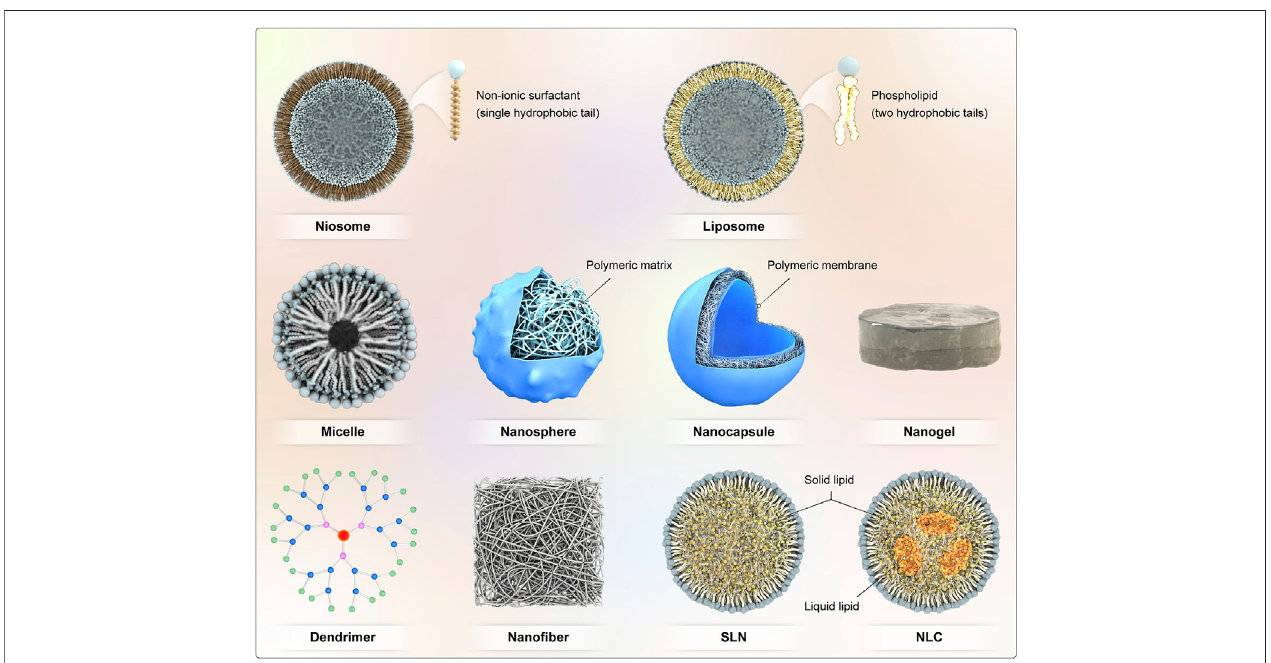
FIGURE 4 | Various nanocarriers for ocular drug